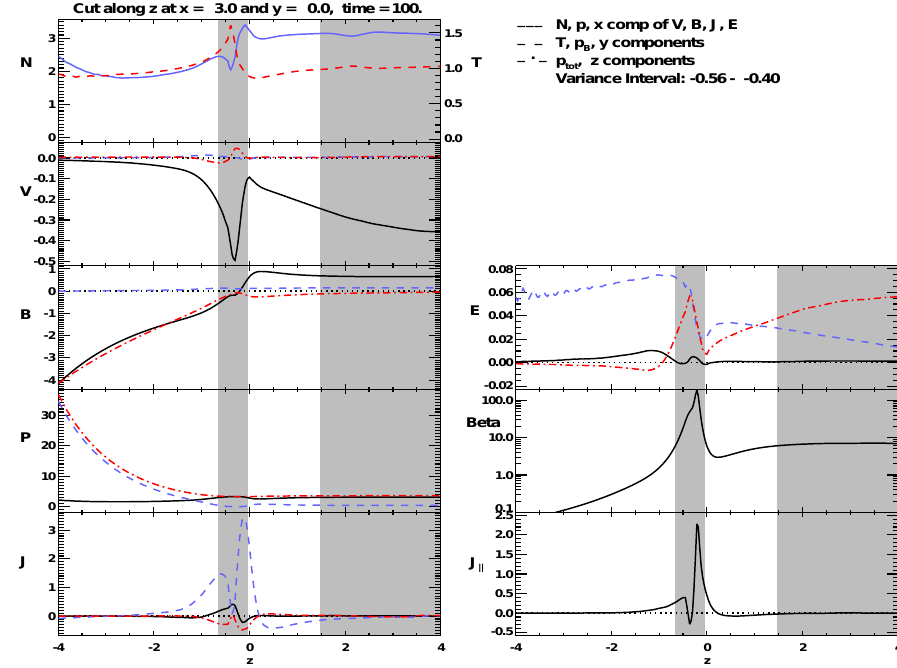
Fig. 11. Simulated data for a cut along z at (x,y) = ( 3 , 0 ) . All quantities are plotted in normalized simulation units. Plotted in the left column from top to bottom are the density, velocity components, magnetic field components, pressure, and current density. The right column displays the electric field, plasma β , and the parallel current density. The shading indicates regions of plasma β > 6.